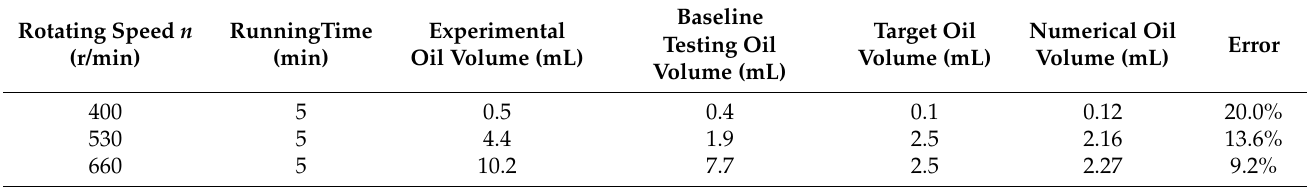
Table 5. Experimental and numerical flow data versus rotating speed.